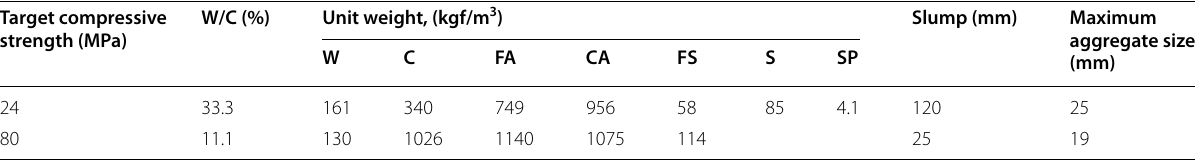
W: water; C: cement; FA: fine aggregate; CA: coarse aggregate; FS: fly ash; S: blast furnace slag; SP: superplasticizer, 1 mm